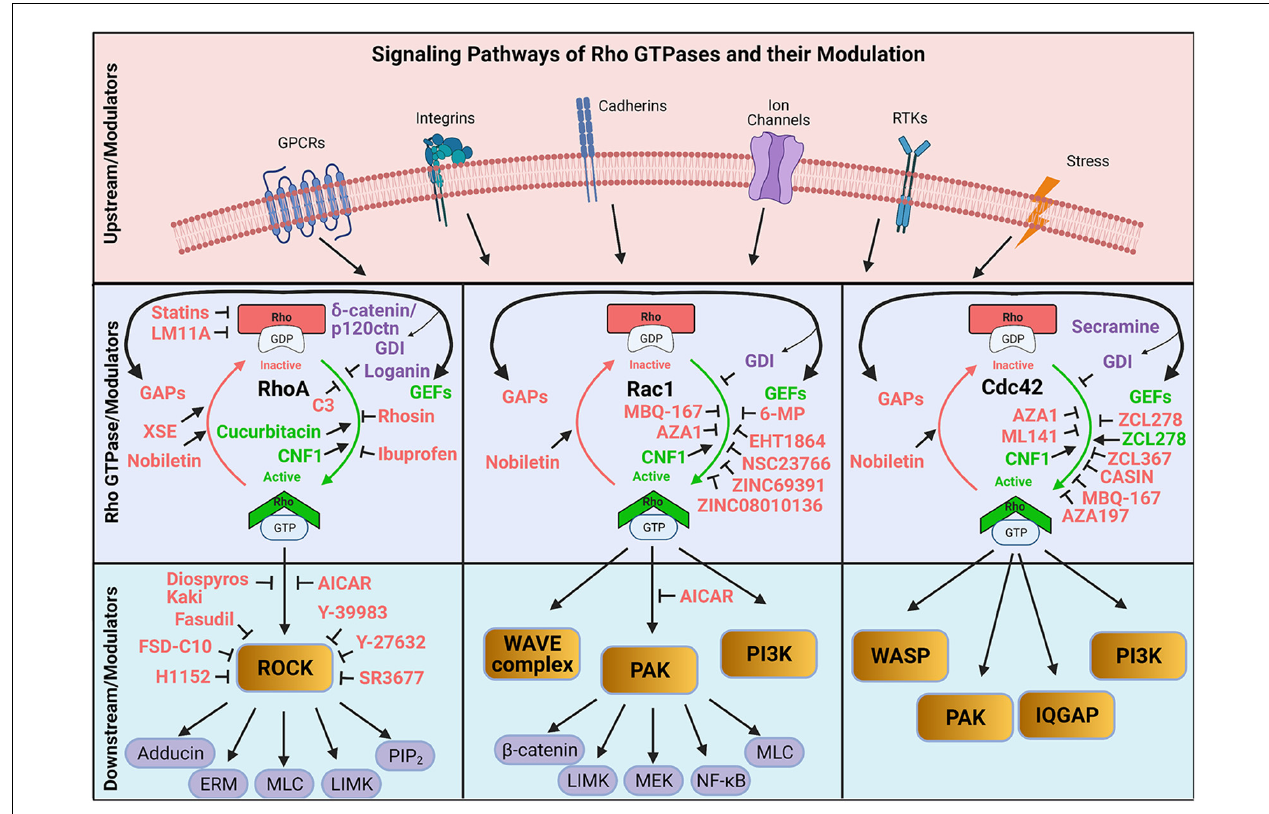
FIGURE 2 | Schematic illustration of the modulation of Rho GTPase activation and inactivation by pharmacological approaches. GEF, Guanine nucleotide exchange factor; GAP, GTPase-activating protein; GDI, GTPase dissociation inhibitor; XSE, Xanthoceras sorbifolia extract; RTK, Receptor tyrosine kinases; PAK, Serine/threonine p21-activated kinases; PI3K, Phosphatidylinositol 3-kinase. Created with